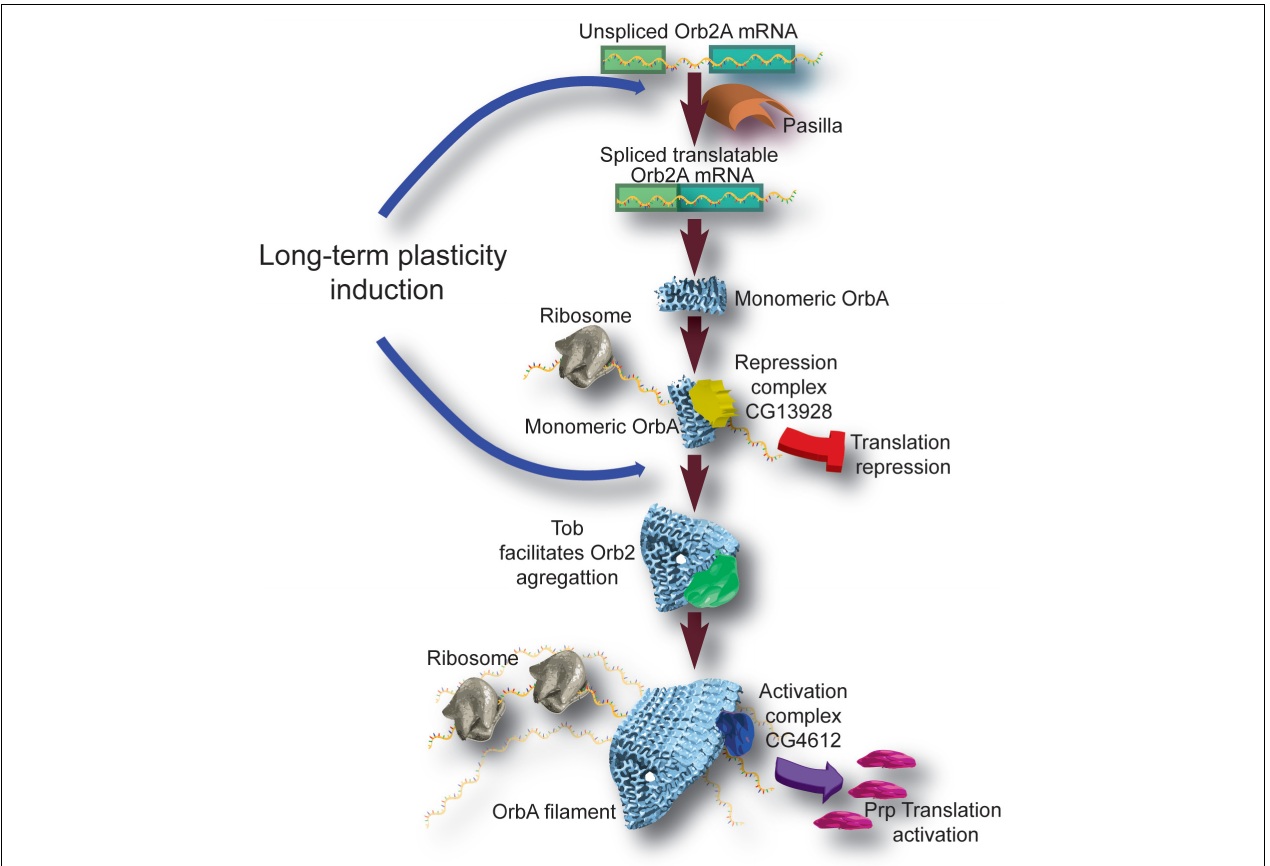
FIGURE 2 | Schematic of role and mechanism of prion-like protein Orb2 in the formation of long-term memory. Long-term inducing plasticity, like appetitive olfactory conditioning engages the splicing regulator Pasilla. Orb2A mRNA is initially transcribed as an unspliced untranslatable mRNA in neuronal cells. Activated Pasilla controls the production of protein-coding translatable spliced Orb2 mRNA. Before oligomerization, CG13928 binds Orb2 monomer and recruits the translation repression complex. In this state Orb2A functions as a translational repressor. Synaptic activation leads to additional Orb2 synthesis. Orb2 is bound and stabilized by the transducer of ERBB2, Tob. This binding promotes Orb2 oligomerization. CG4612 binds aggregates Orb2 and recruits a translation promoting complex. In this state Orb2 works as a translational activator. Orb2 protein switches from repressing to activating translation when aggregates and forms amyloid-like oligomers. It is proposed that the translation activation of Orb2 is involved in the translation of plasticity-related proteins like tequila, PKC, and Murashka and therefore sustains long-term memory. Because prion-like proteins are self-assembling molecules and can self-perpetuate, Orb2 function provides an attractive mechanism for synapse-specific plasticity and memories that outlast the lifetime of individual protein